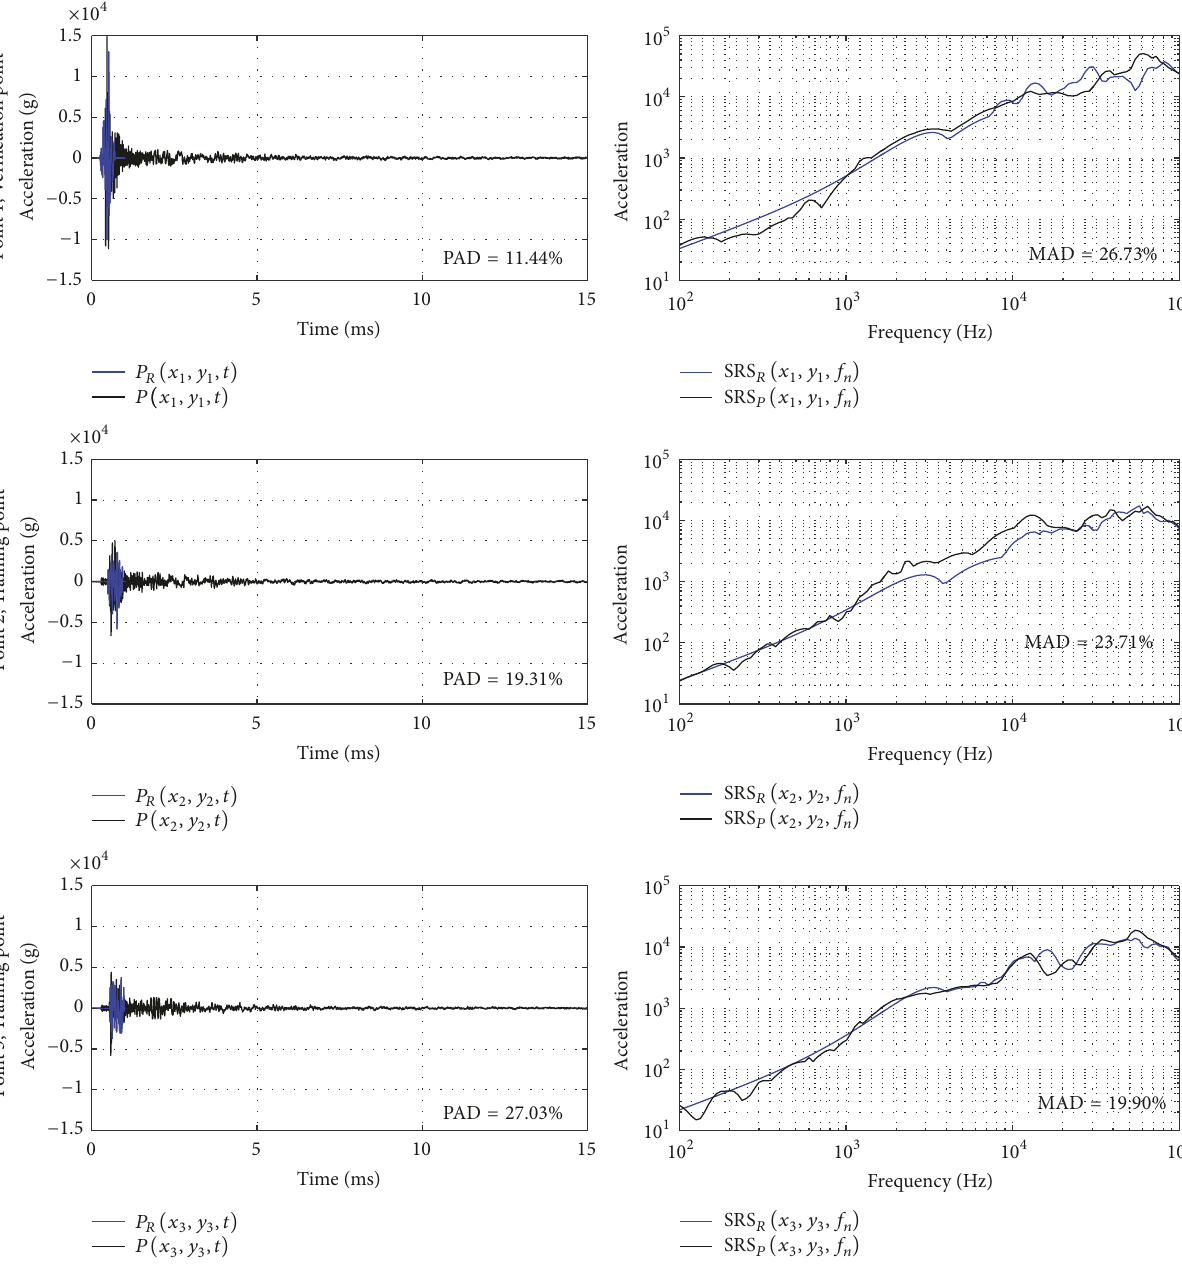
Figure 20: Time domain signal reconstruction result in using point 1 as a verification